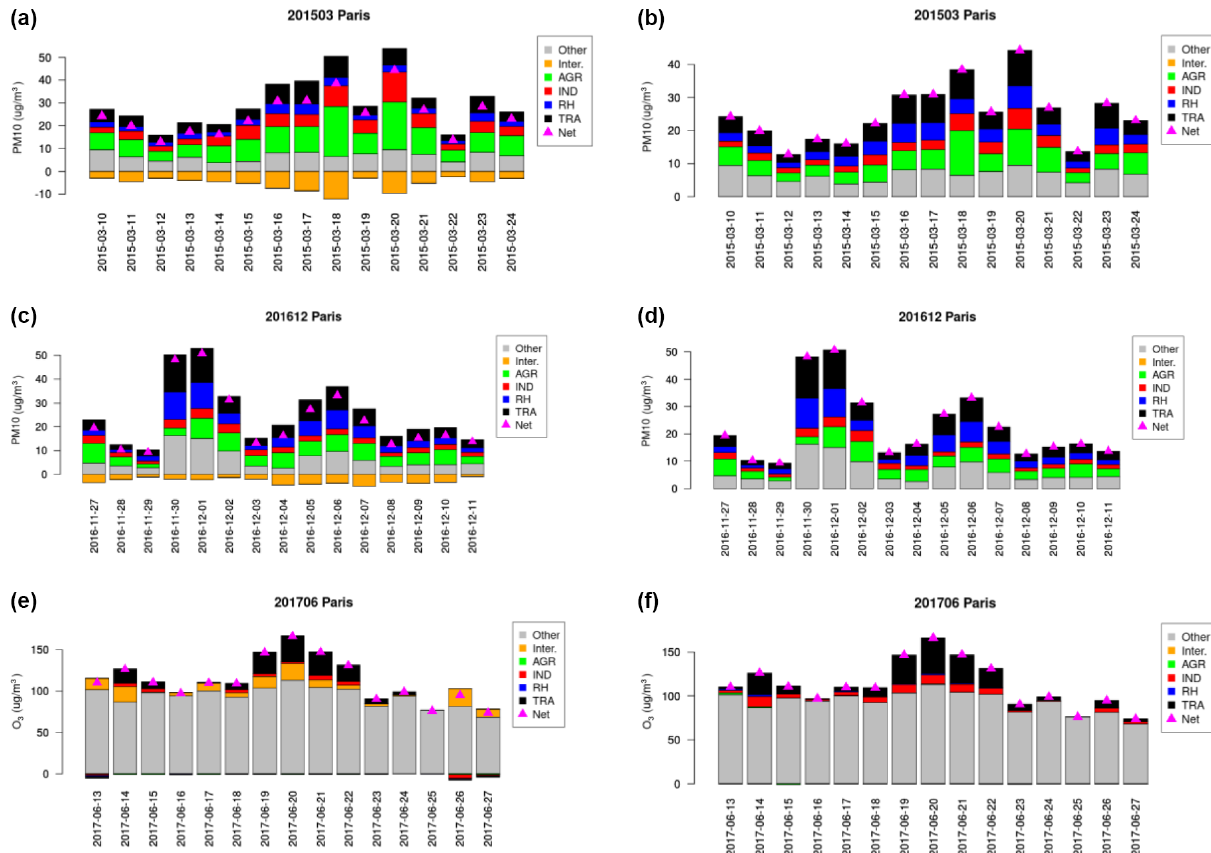
Figure 15. Source allocation using the ACT surrogate model for PM 10 in March 2015 (a, b) and December 2016 (c, d) and for O 3 June 2017 as in absolute levels (µgm − 3 ) with explicit (a, c, e) or redistributed (b, d, f) interaction terms.